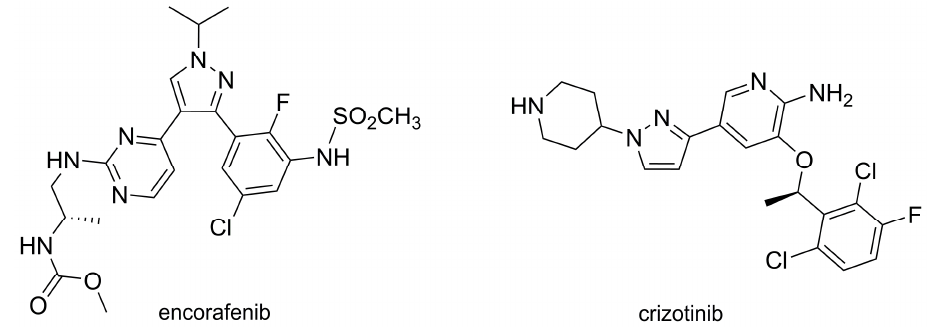
Figure 3. Antitumor pyrazoles available in the market: encorafenib (tradename Braftovi ® ) and crizotinib (tradename Xalkori ® ).